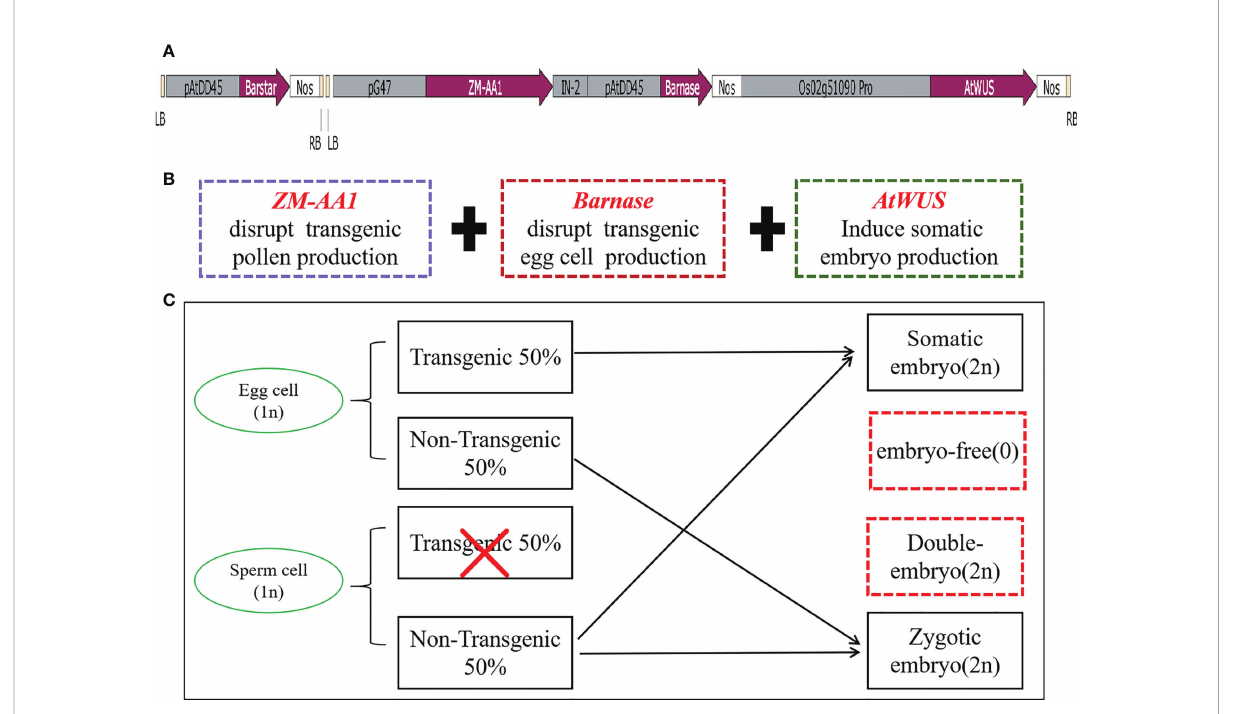
FIGURE 1 The transformation vector and model of the asexual seed propagation system. (A) Schematic diagram of the p22W vector construct containing two T-DNA regions. LB, left T-DNA border; pAtDD45, Arabidopsis DD45 promoter; Barstar, Barstar gene; NOS, nopaline synthase terminator; RB, right T-DNA border; pG47, pG47 promoter; ZM-AA1, ZM-AA1 gene; IN-2, IN-2 terminator; Barnase, Barnase gene; Os02g51090pro, Os02g51090 promoter; AtWUS, Arabidopsis WUS gene. (B) The function of the three gene expression cassettes in the T-DNA. (C) Schematic model for generating asexual seed propagation in hybrid